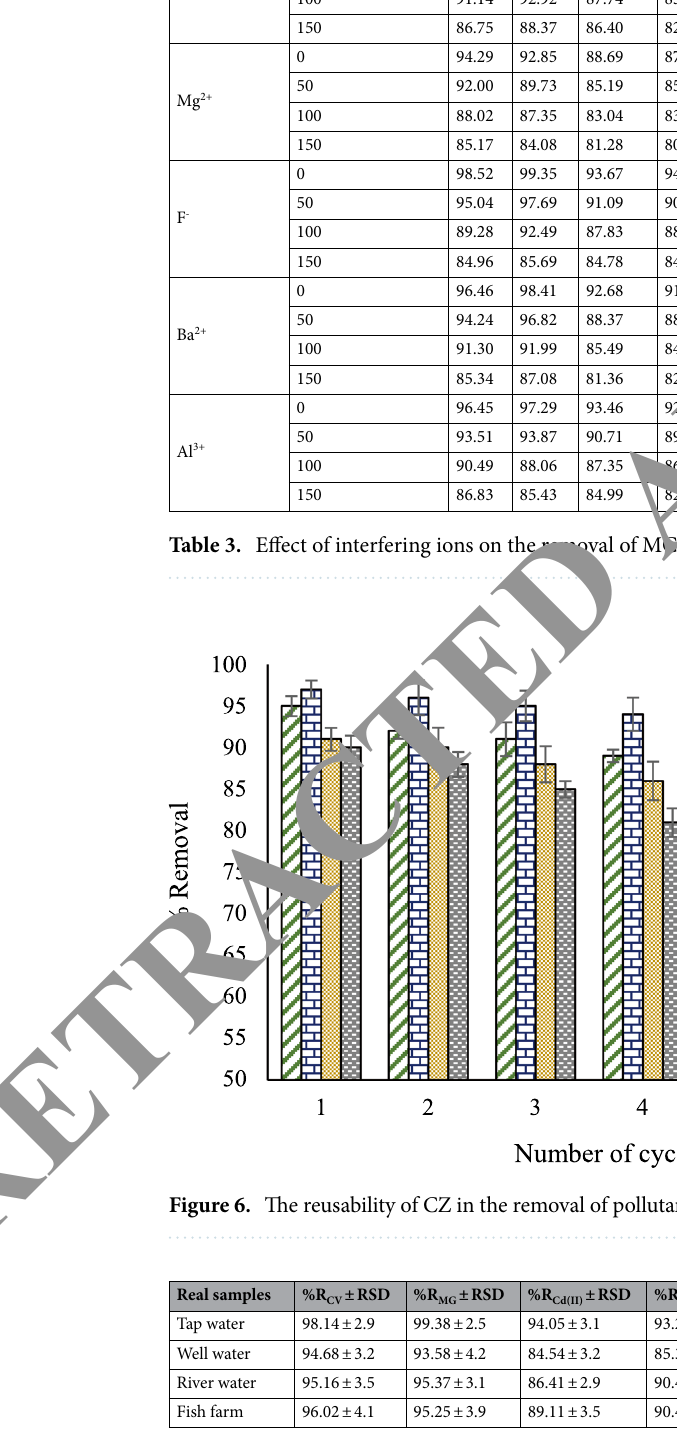
Table 4. Removal of CV, MG, Cd(II) and Pb(II) in real samples.